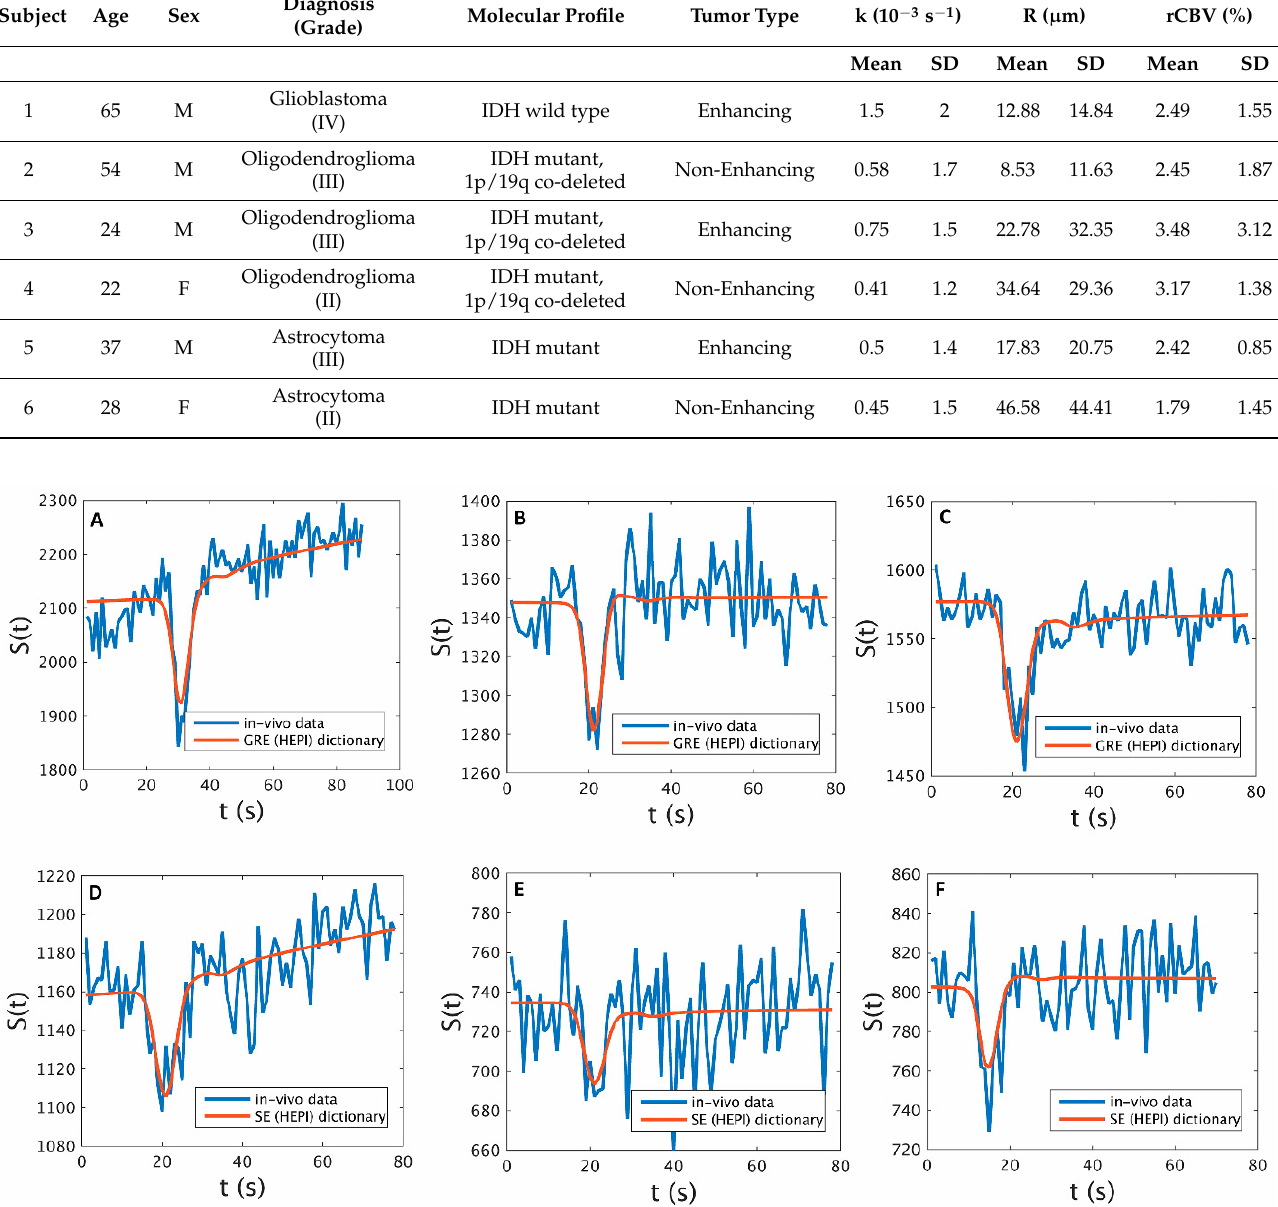
Figure 3. Signals from a tumor voxel in patients 1, 2 and 3 from GRE (( A , B , C ), respectively) and SE (( D , E , F ), respectively) images (blue) and their best match according to the respective GRE and SE of the HEPI dictionary (red).